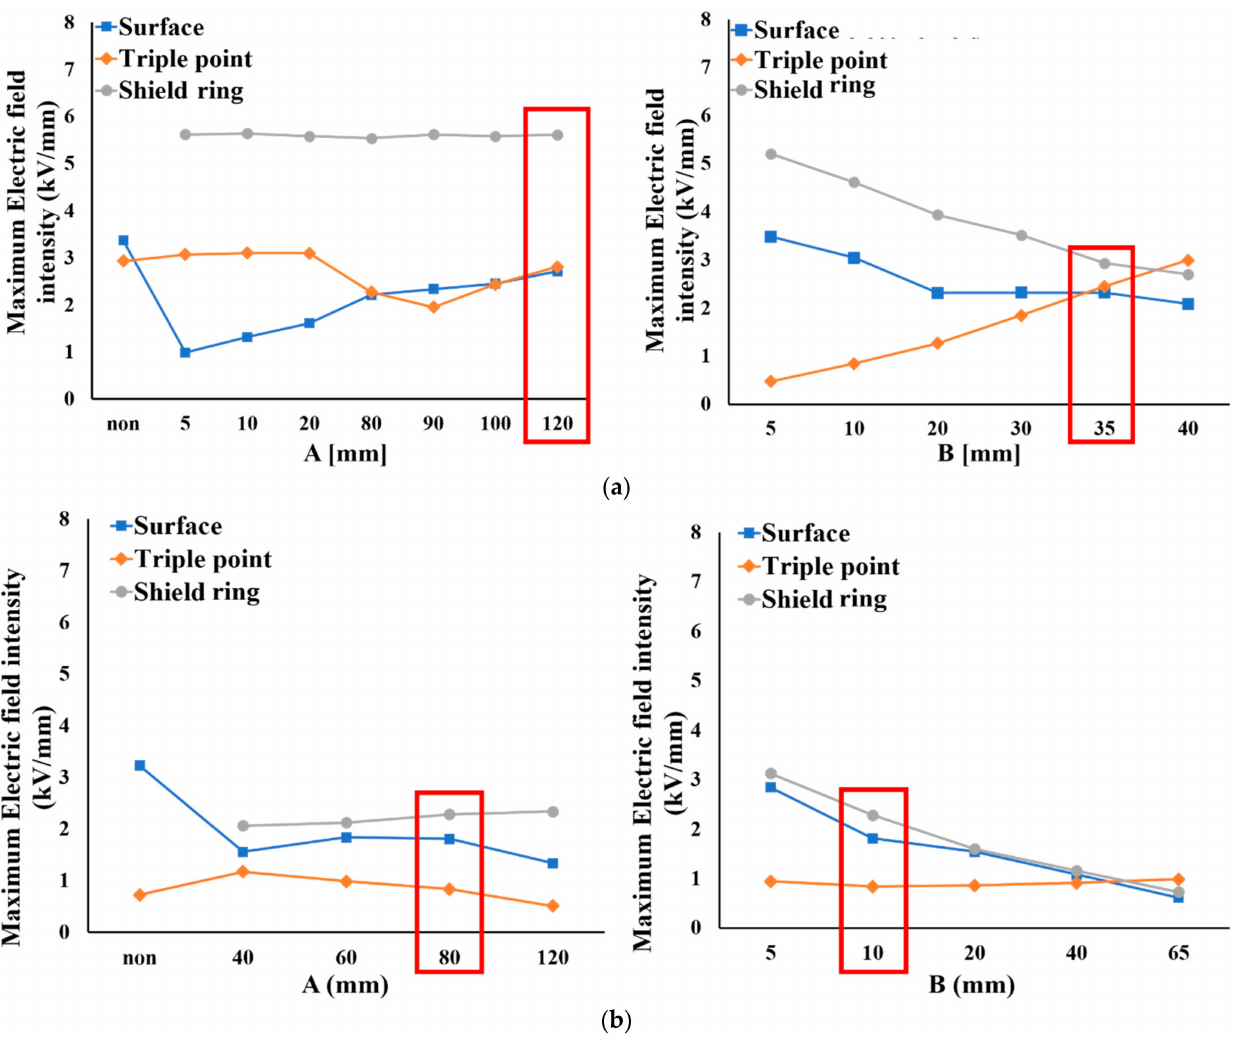
Figure 8. Electrical characteristics of the insulator according to the design factors. ( a ) Post insulator. ( b ) Interlay